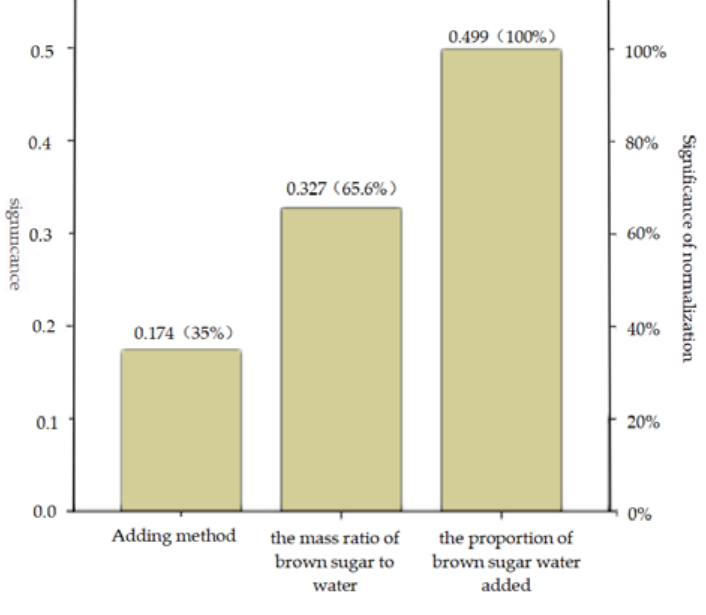
Figure 9. Chart of factor significance.